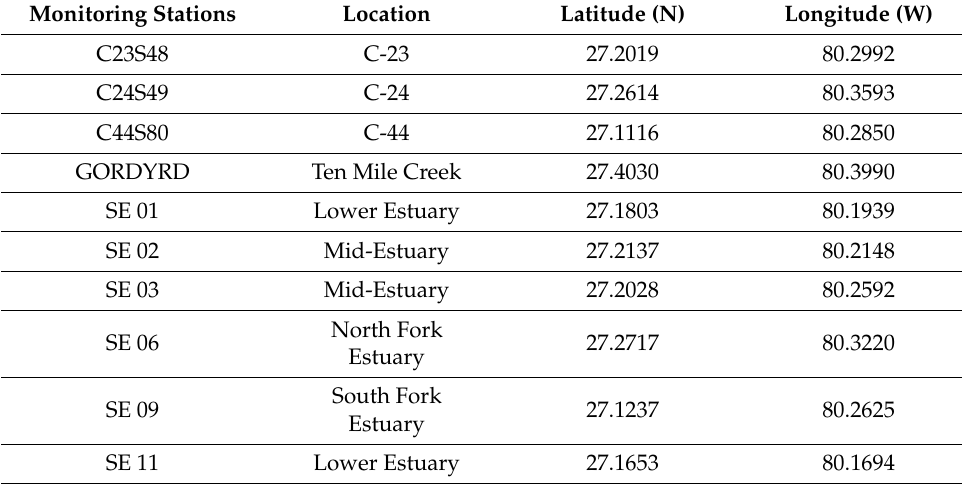
Table 1. Location of water monitoring